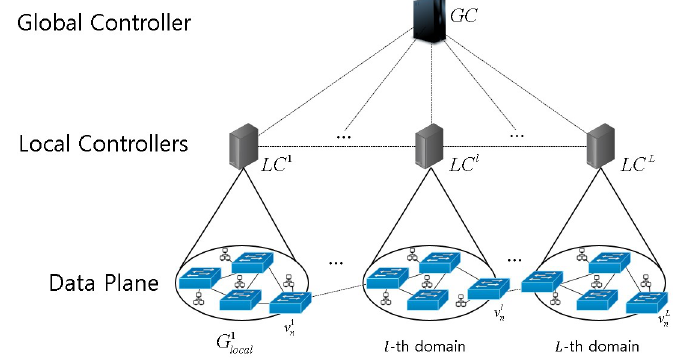
Figure 1. Network